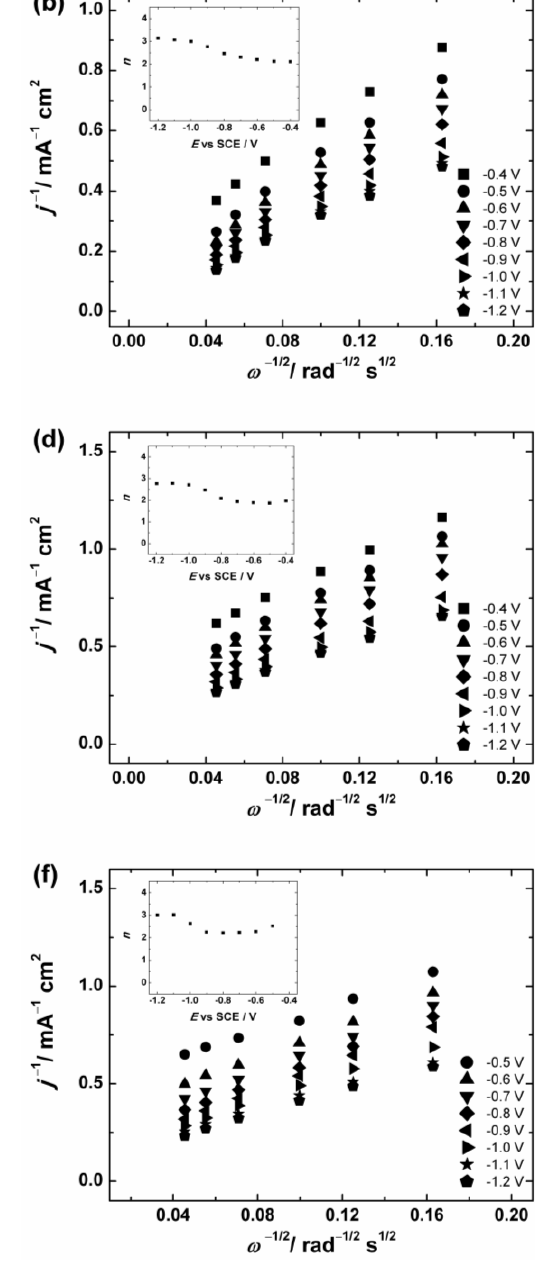
Figure 6. ( a , c , e ) RDE (rotating disc electrode) voltammetry curves and ( b , d , f ) Koutecky–Levich plots for oxygen reduction on GC electrodes coated with: ( a , b ) graphene nanopowder (from Graphene Supermarket); ( c , d ) graphene nanoplatelet aggregates (from Strem Chemicals); and ( e , f ) reduced graphene oxide in O 2 -saturated 0.1 M KOH. ν = 10 mV·s −1 . The insets show the potential dependence of n . The electrodes were prepared using the catalyst ink suspension in 2-propanol containing OH − ionomer.